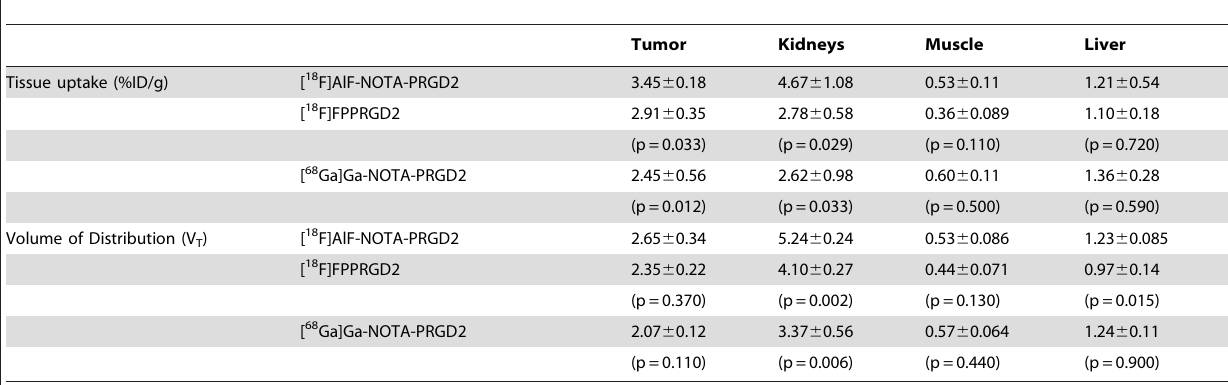
Table 1. Estimated parameter values from static images and kinetic modeling.